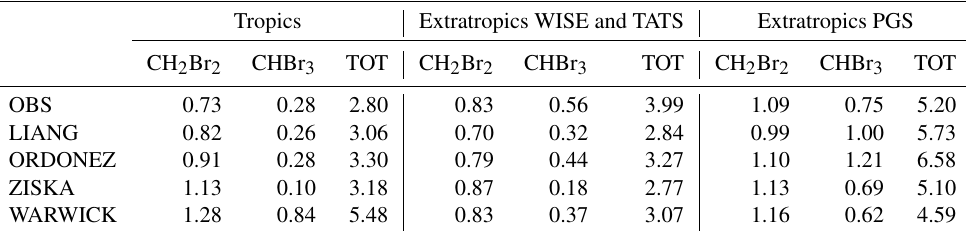
Table 5. Mixing ratios of organic VSLS bromine in air at the tropical, and respectively extratropical (40–60 ◦ N), tropopause (Br ex-trop org and Br trop org ) used in the calculation of inorganic bromine (Br y ) for the observation (OBS), and respectively the models, using the emission scenarios of Liang et al. (2010), Ordóñez et al. (2012), Ziska et al. (2013) and Warwick et al. (2006). For the Warwick et al. (2006) scenario, the data have been derived from the EMAC model, while for the other scenarios the TOMCAT model has been used. For the tropics, annual average for the years 2012 to 2016 have been calculated between 10 ◦ N and 10 ◦ S in a potential temperature range from 365 to 375K. The tropical mixing ratios for the observations are from the observations compiled in the 2018 WMO report (Engel and Rigby, 2018) in the tropics between 365 and 375K potential temperature. All data presented are shown in parts per